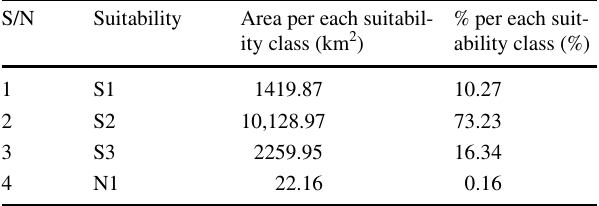
Fig. 14 Map of land suitability for irrigation Table 10 Distribution of land suitability for irrigation